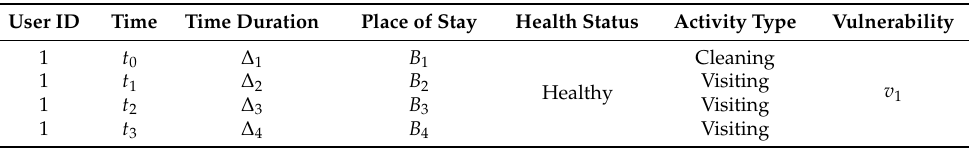
Table 2. Semantic indoor movement trajectory of a